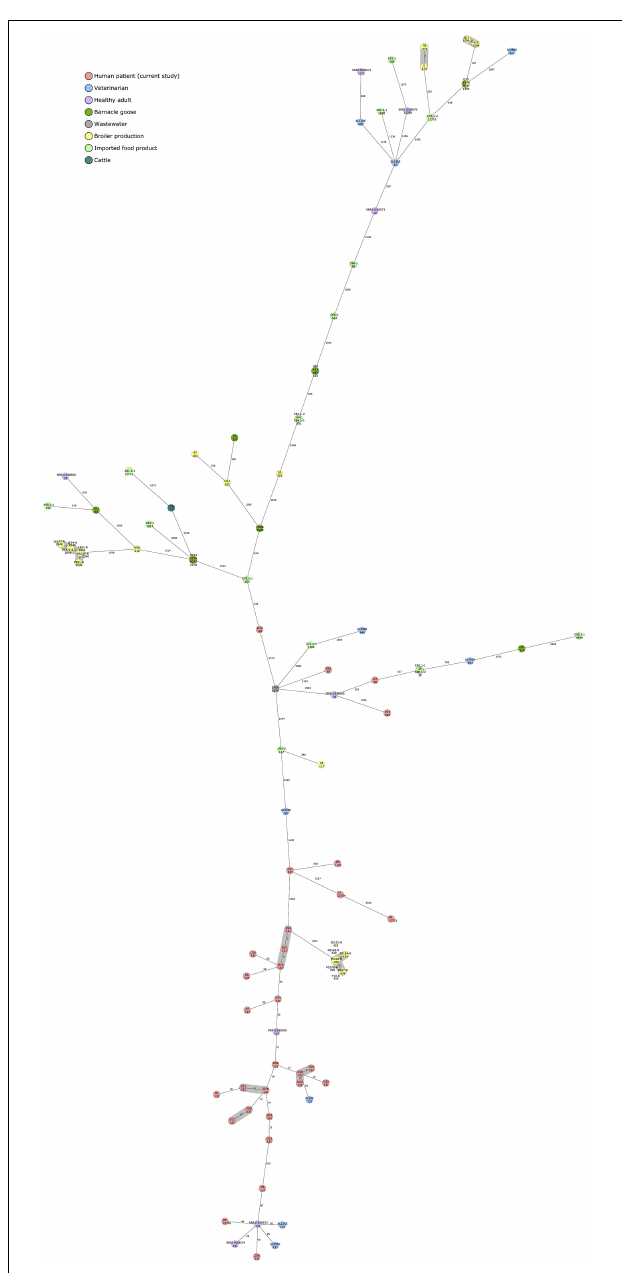
FIGURE 3 | Minimum spanning tree of 97 ESBL/AmpC-producing Escherichia coli isolates calculated in Ridom SeqSphere+ with 2513 core genome multilocus sequence typing (cgMLST) targets and 7 E. coli MLST Warwick targets (pairwise ignoring missing values, logarithmic scale). Nodes are colored according to isolation source. Sequence type is indicated under the isolate name. Number of allelic differences between isolates are indicated on the connecting lines. Clusters are defined as ≤ 10 allelic difference and shaded in